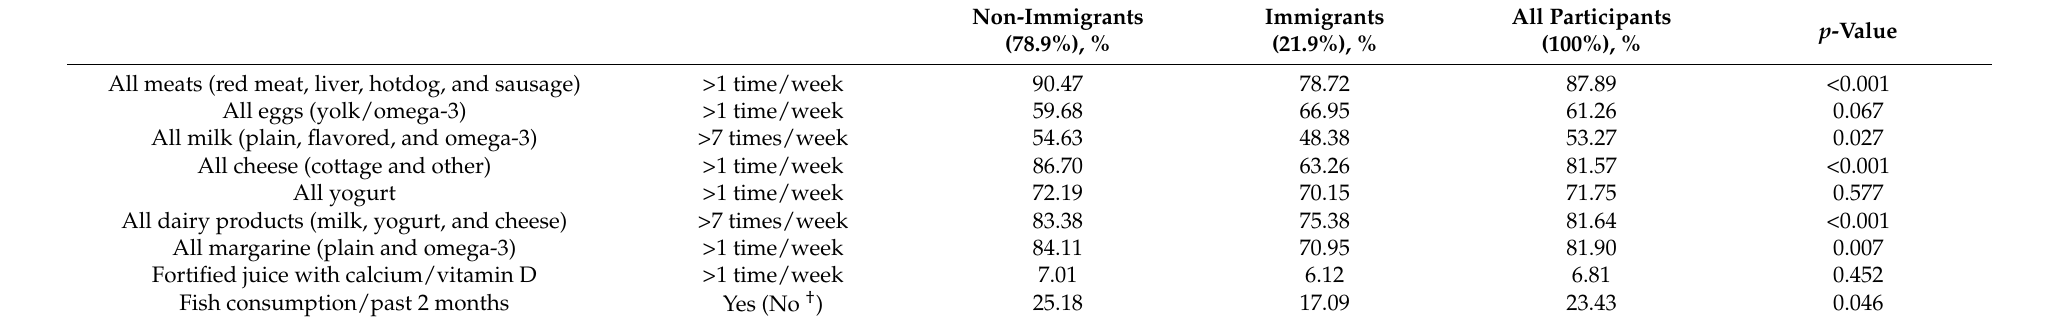
Non-Immigrants Immigrants All Participants p -Value (78.9%), % (21.9%), % (100%), %